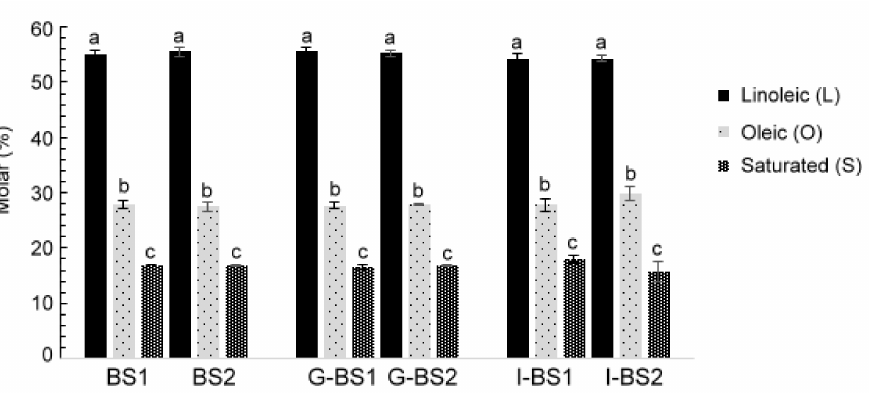
Figure 2. Molar percentage of linoleic, oleic and saturated fatty acids (FA) plus acyl groups (AG) (FA+AG) in relation to the total moles of all kinds of AG and FA (FA+AG) in black seed oils 1 and 2 (BS1 and BS2) and in the digestates of these oils after gastric (G-BS1 and G-BS2) and intestinal (I-BS1 and I-BS2) digestion. Different letters indicate statistically significant differences among the samples analyzed by one-way ANOVA ( p <